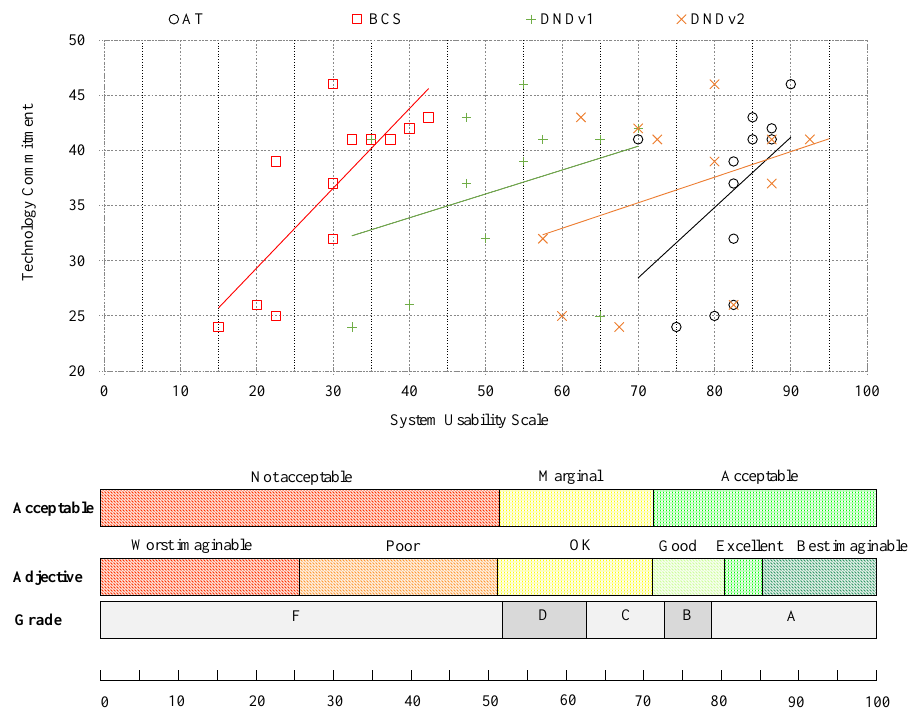
Figure 3. Overview of the SUS results of DNDv1 (mean SUS = 51.66), the AT (mean SUS = 82.50), and the BCS (mean SUS = 29.79) from Study 1, as well as the SUS results of DNDv2 (mean SUS = 76.40) from Study 2 in relation to conventional ranking, using grades, adjectives, and acceptance levels in correlation with the TC score. SUS, System Usability Scale; DNDv1, digital nutrition diary version 1; AT, activity tracker; BCS, body composition scale; DNDv2, digital nutrition diary version 2; TC, Technology